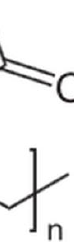
Figure 7. Repetitive unit of PVP.